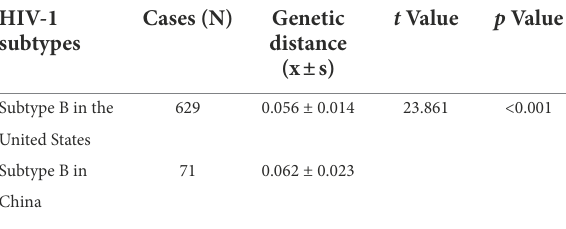
TABLE 3 Gene distances of two subtypes of HIV-1